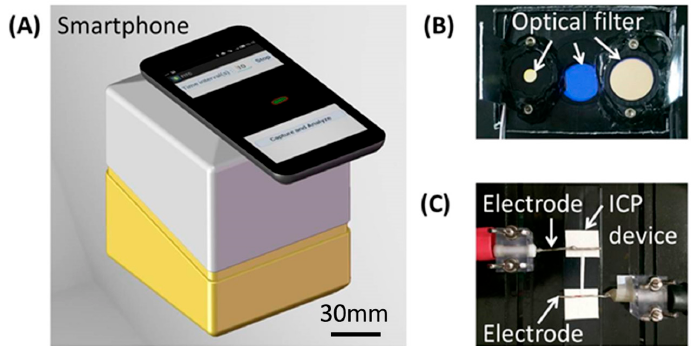
Figure 3. Experimental setup with smartphone detection. ( A ) Instrument box with a smartphone; ( B ) Optical module; ( C ) ICP device with applied electrodes.